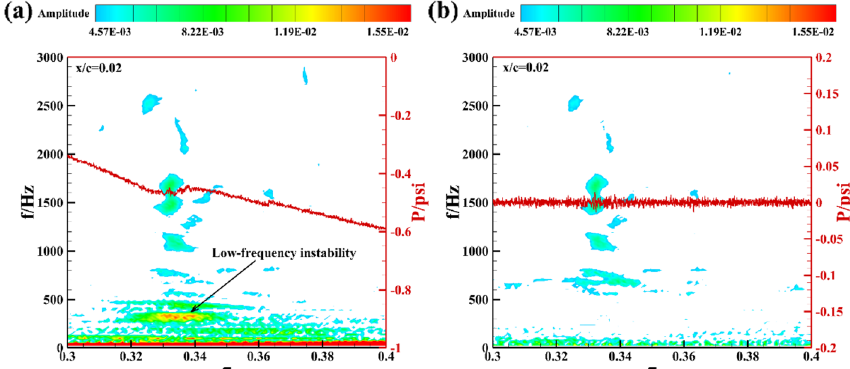
Fig. 10 Time-frequency analysis at x / c